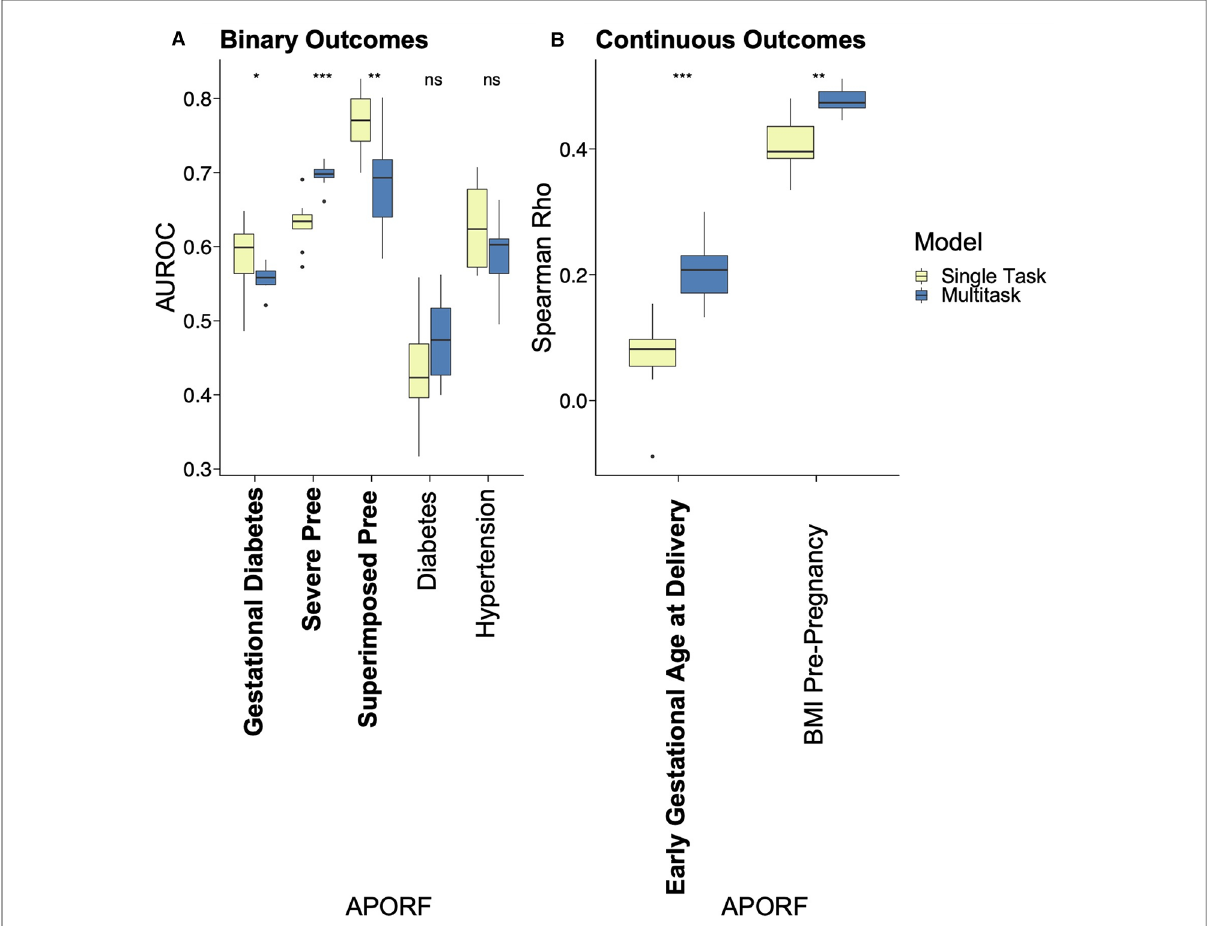
FIGURE 7 Multitask and single task machine learning analysis for the prediction of APOs based on generated immune features. APOs are bolded, and pathophysiological RFs are unbolded. Results of multitask models are blue, and single task models are yellow. Prediction of APOs was successful with generated immune features, con fi rming their biological relationship. Asterisks represent signi fi cant differences calculated by the Wilcoxon rank-sum test between single task and multitask approaches, with an increasing number of asterisks representing increased signi fi cance. Thresholds for signi fi cance include - ns: p >0.05, * p <=0.05, ** p <=0.01, *** p <=0.001, and **** p